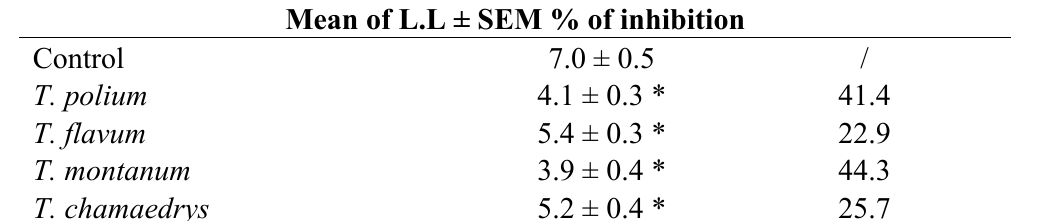
Table 2. Effect of Teucrium flavum , T. chamaedris , T. polium and T. montanum essential oils on CMV